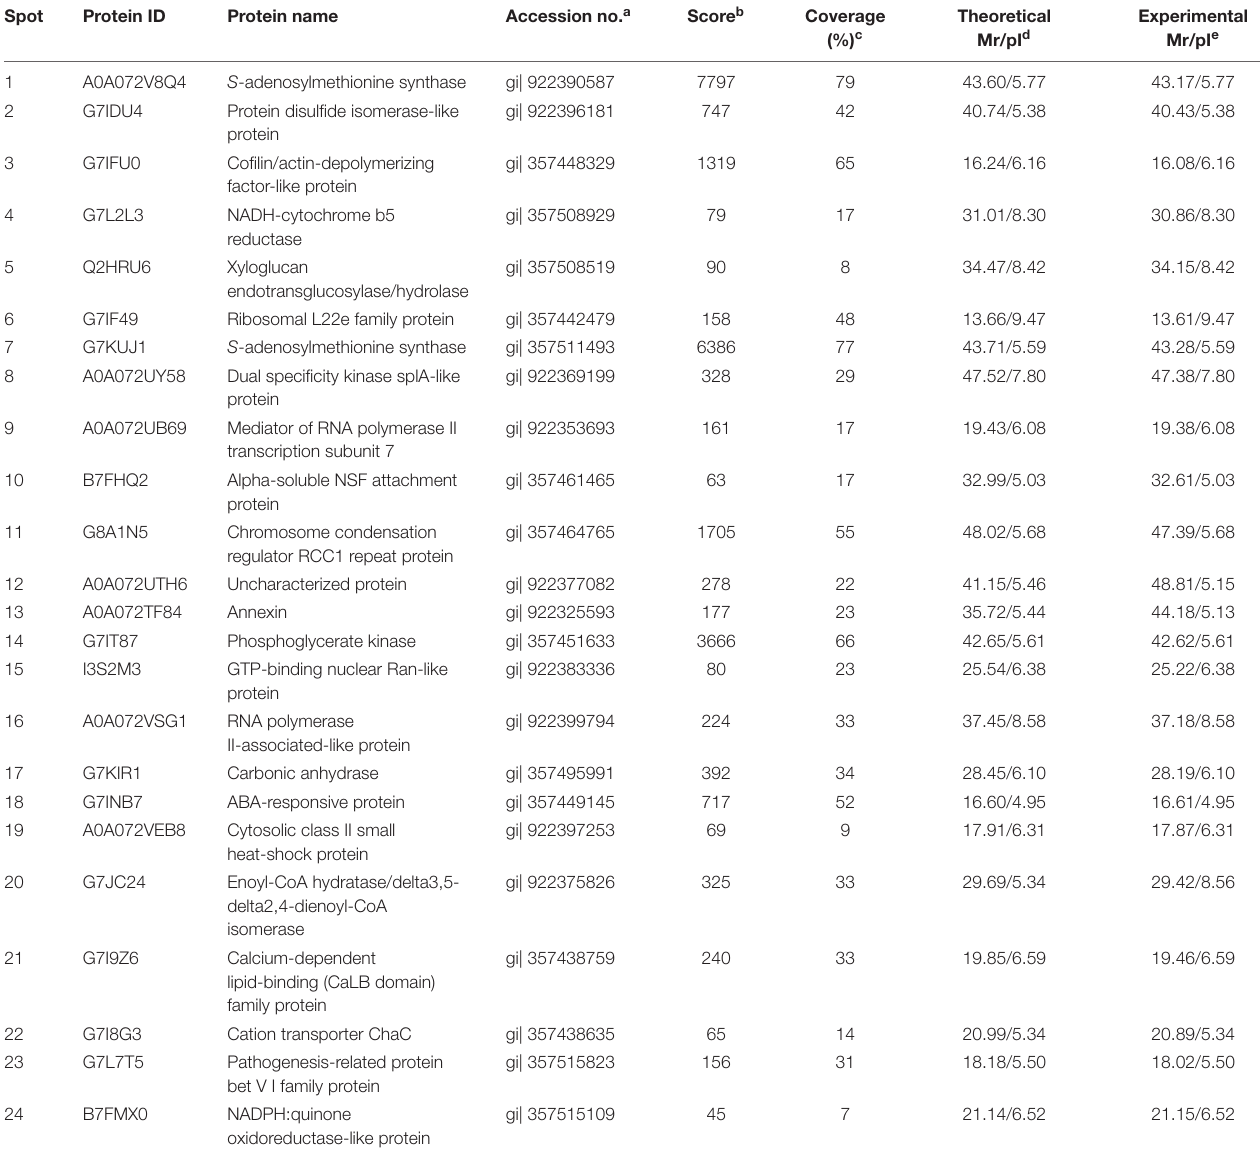
TABLE 1 | Differentially expressed proteins identified by LC-MS/MS during alfalfa flower development.